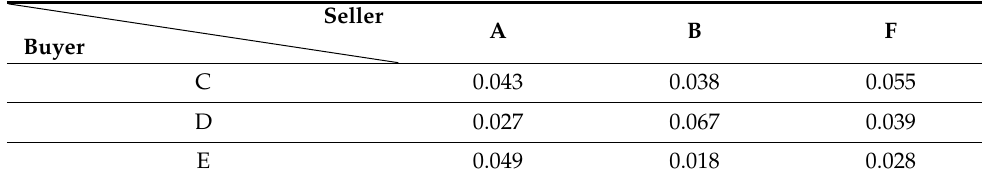
Table 2. The calculation example of cost paths (USD/kWh) .